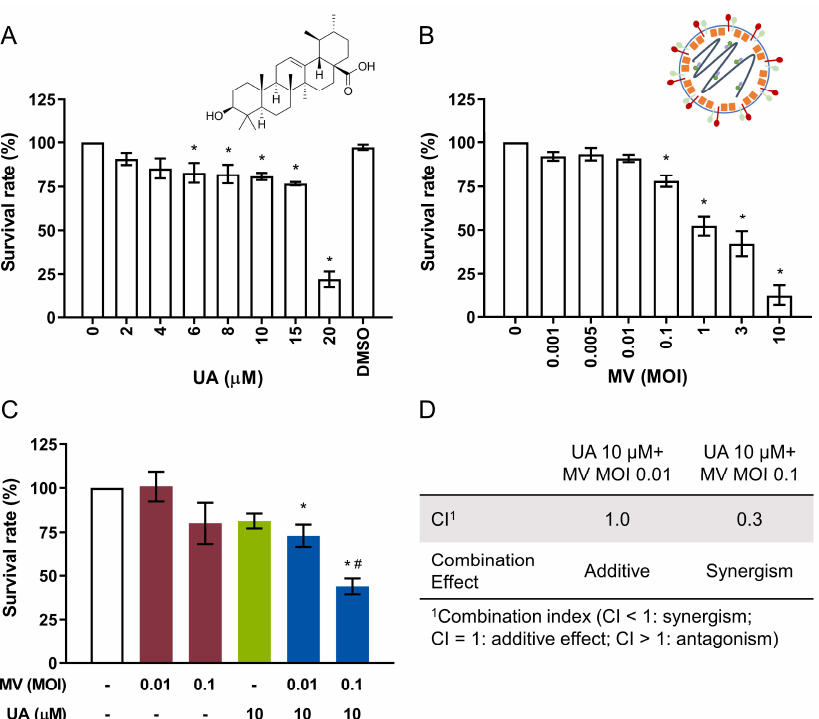
Figure 1 Figure 1. Ursolic acid (UA) and oncolytic measles virus (MV) are cytotoxic to human breast cancer MCF-7 cells and synergistically induce anticancer activity. ( A ) MTT cell viability analysis of MCF-7 cells treated with UA (2–20 µ M) for 5 days. ( B ) MTT cell viability analysis of MCF-7 cells treated with MV (multiplicity of infection, MOI 0.001–10) for 5 days. ( C ) MTT cell viability analysis of MCF-7 cells treated with UA (10 µ M) and MV (MOI 0.01 or 0.1) concurrently for 5 days. ( D ) Analysis of treatment synergism using the Chou–Talalay method wherein combination index (CI) value quantitatively defines synergism (CI < 1), additive effect (CI = 1), or antagonism (CI > 1). All data shown are means ± SEM from three independent experiments; * p < 0.05 in ( A , B ) compared to ‘0’; * p < 0.05 compared with MV MOI 0.01 or 0.1, # p < 0.05 compared with UA treatment only in ( C ); DMSO = 0.2% (the maximum concentration of DMSO